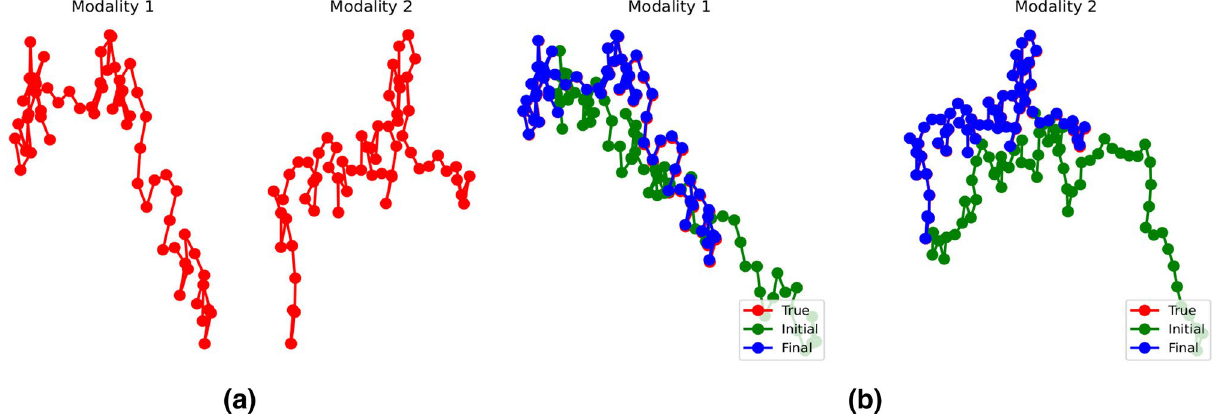
Figure 2. ( a ) Generated toy proteins examples ( N = 64 ) and ( b ) reconstruction from compressed sensing observations. With 2 out of 64 measurements (3.125%), near perfect reconstruction is possible even though the modalities are individually subsampled.